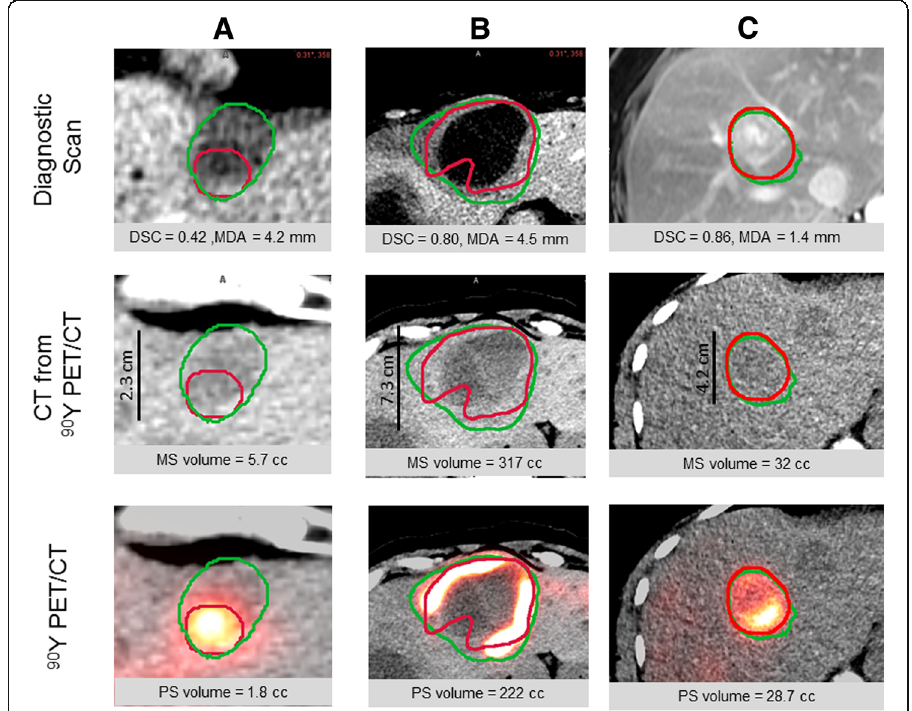
Fig. 2 Three examples ( a – c ) showing PET-based (red) and morphologic (green) segmentations on a single axial slice. Note the scale is different across the three cases and the metrics were evaluated over the full 3D extent of the